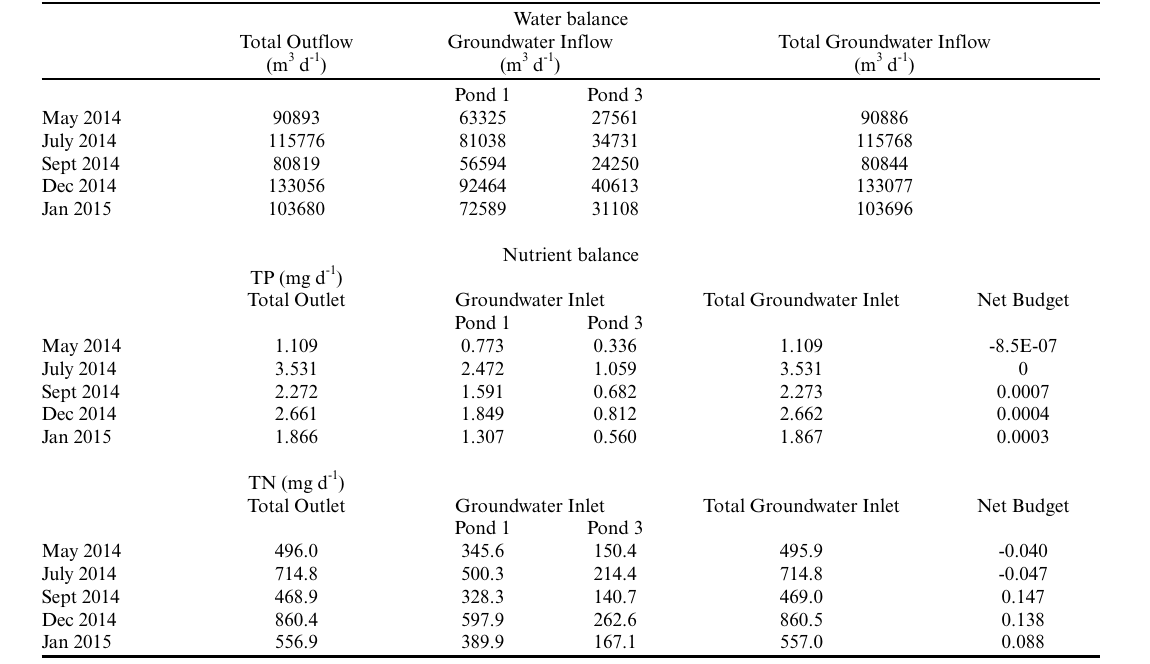
Table 2 . Ewens Ponds water balance and nutrient balance as calculated from equations 2 and 3. Groundwater inflow from pond 2 was negligible and is therefore not shown.